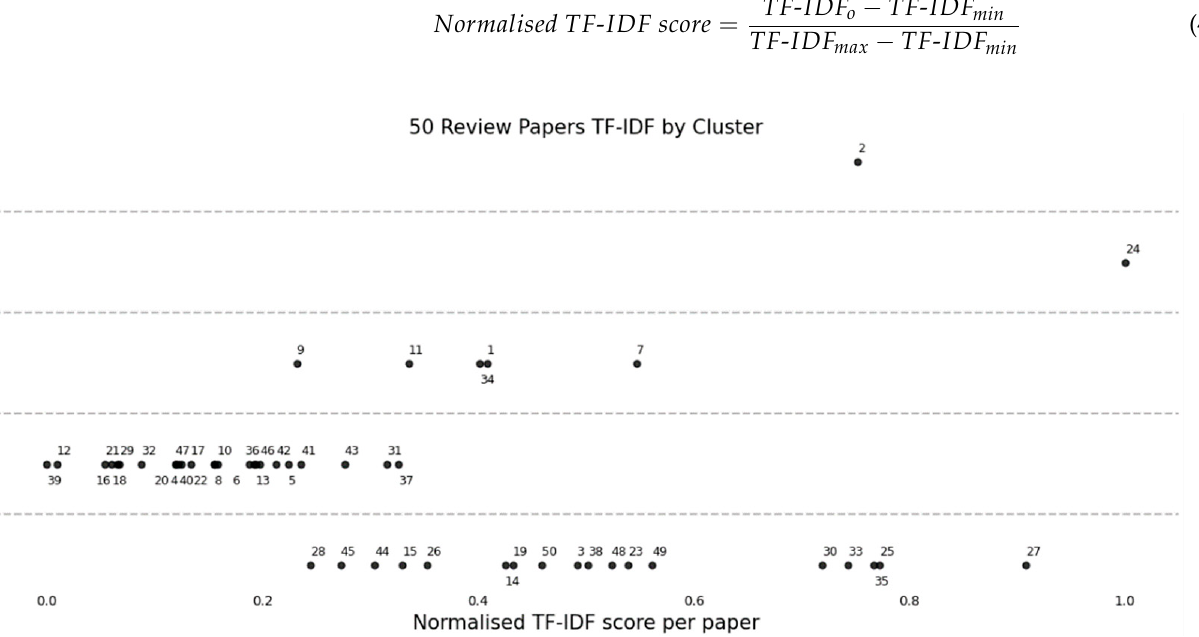
Figure 4. Fifty review papers analysed by TF-IDF and clustered using K-means, subsequently plotted within respective clusters against a normalised TF-IDF score per paper.